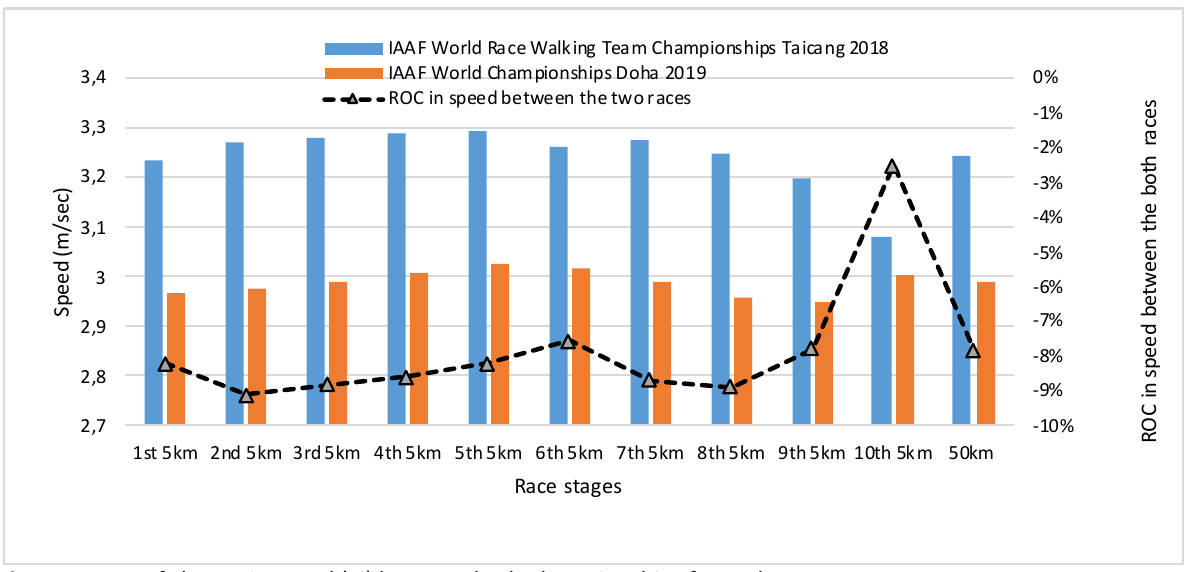
Figure 4 . Rate of change in speed (%) between both Championships for each stage. Table 5. Correlation coefficients (r) between the performance times averages of stages and with final 50km in WAC2019. Race Stages